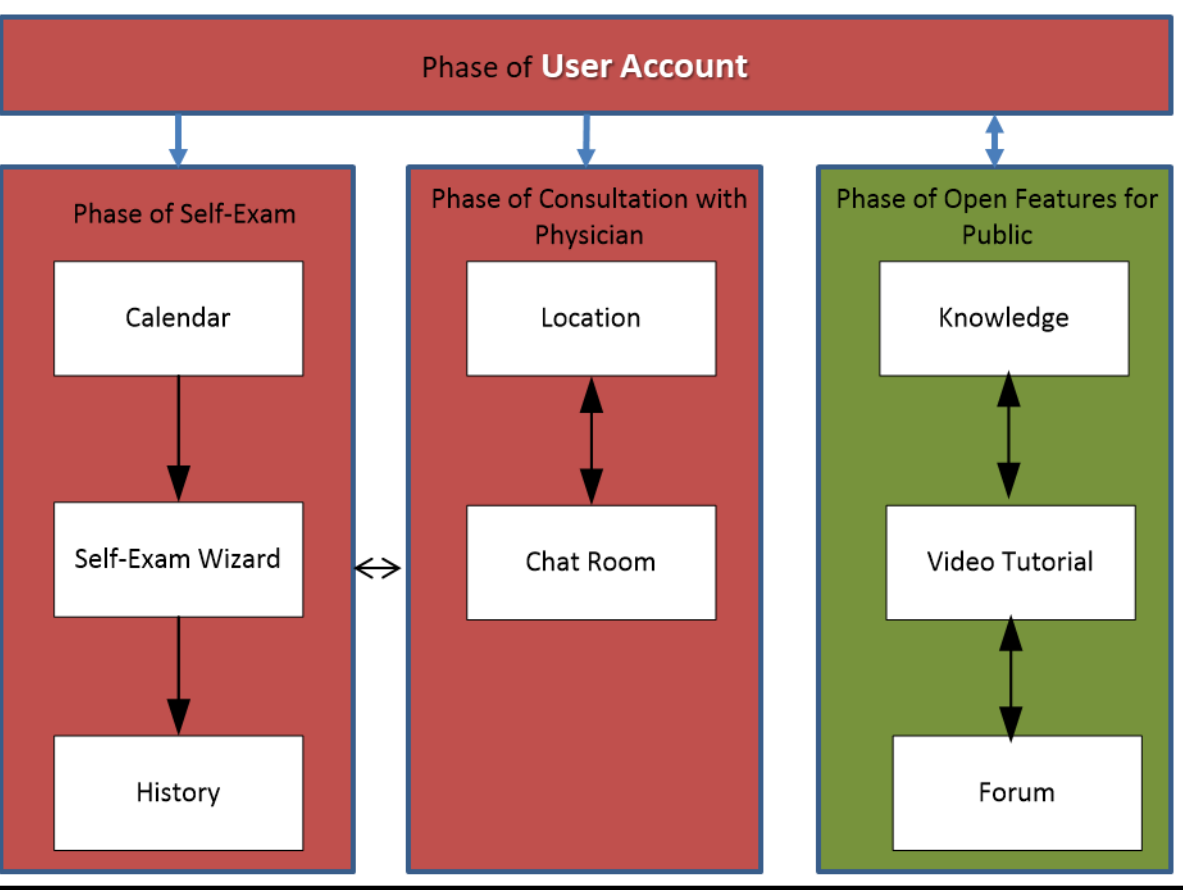
Figure 4. Module design of the breast self-examination (BSE) system